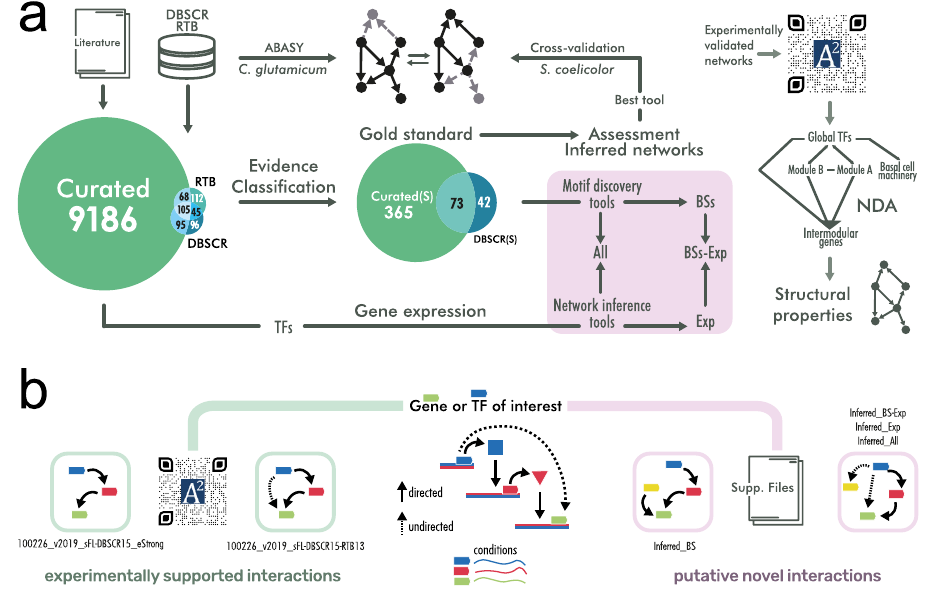
Figure 1. ( a ) Workflow of this work. The purple area covers the inference of the networks. ( b ) Type of interactions contained in the networks. The green path connects to curated regulations supported by experimental evidence. The “ strong” network contains only the interactions that are supported by an experiment proving that the transcription factor binds a DNA site near a target gene to regulate its transcription. Curated networks without the “strong” label might contain indirect interactions, as they could be supported by non- directed experiments (such as gene knockout and its effect on genes transcription). The purple path connects to inferred interactions. Predictions based solely on binding sites predictions would be inferring only TF-DNA interactions. Predictions involving gene expression data might contain indirect interactions.